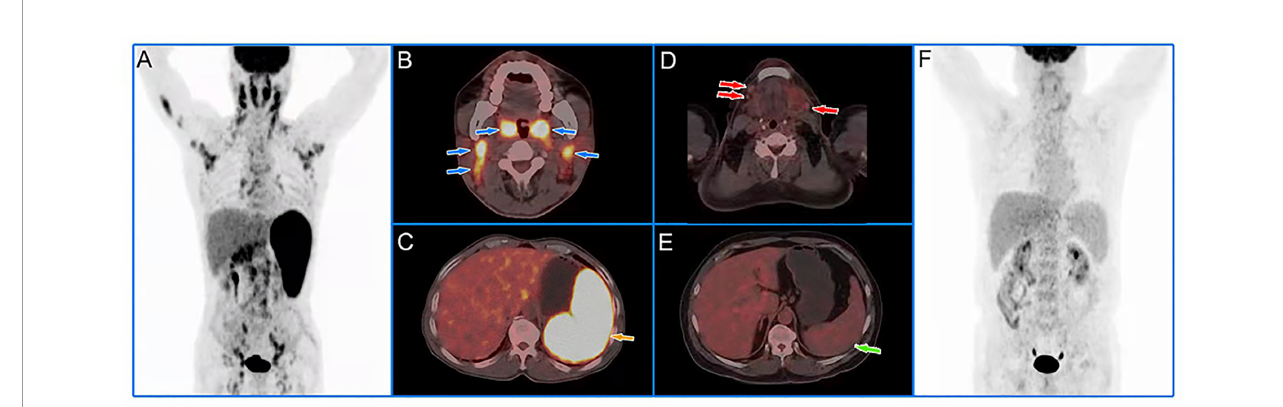
FIGURE 4 | Representative cases of baseline 18 F-FDG PET/CT images. A 60-year-old male patient with low HI had extensive lymph node lymphoma invasion and lymphoma in fi ltration into the oropharynx and spleen (A) . The blue and yellow arrows represented the oropharynx, cervical lymph nodes (B) , and spleen (C) , respectively. The lesions had an SUV max of 11.09, an SUV mean of 7.10, and a HI of 1.56. We followed up for 39 months and the patient had no recurrence. A 55- year-old male patient with high HI had extensive critical-sized lymph node lymphoma invasion and no lymphoma in fi ltration into the organs (F) . The red and green arrows represented the submaxillary lymph nodes (D) and spleen (E) , respectively. The lesions had an SUV max of 3.35, an SUV mean of 1.13, and a HI of 2.96. The patient developed local recurrence after 29 months of